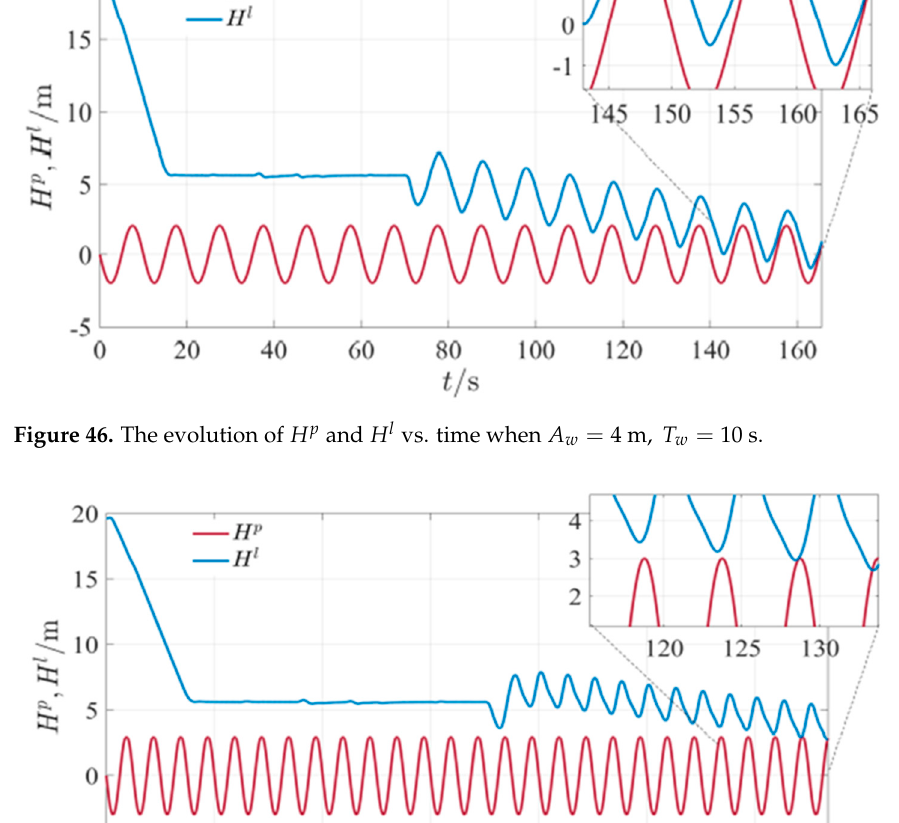
Figure 47. The evolution of H p and H l vs. time when A w = 6 m, T w = 5 s.